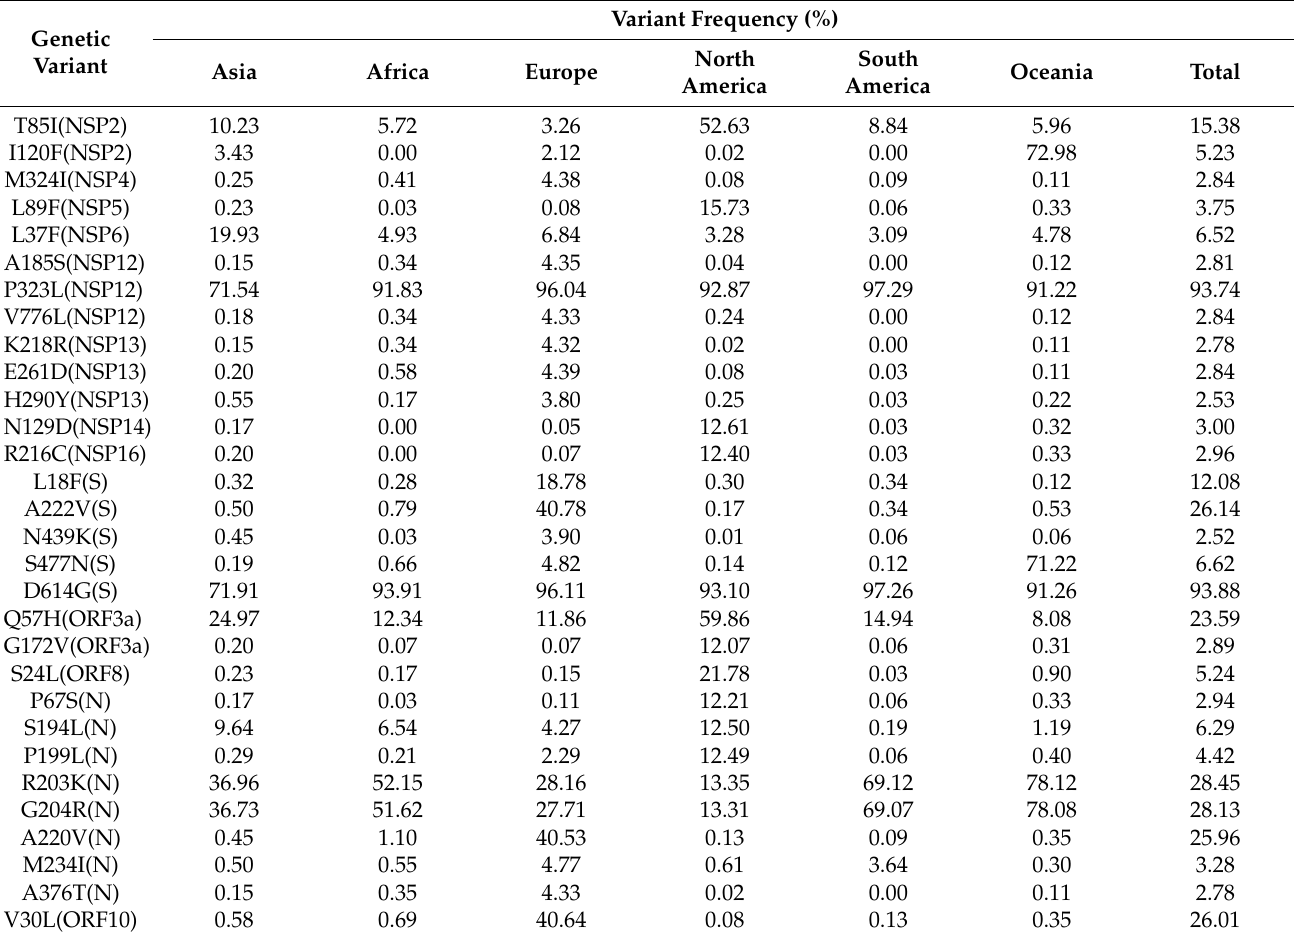
Table 2. The overall prevalence of SARS-CoV-2 variants in a large-scale dataset of 260,673 sequences. Genetic